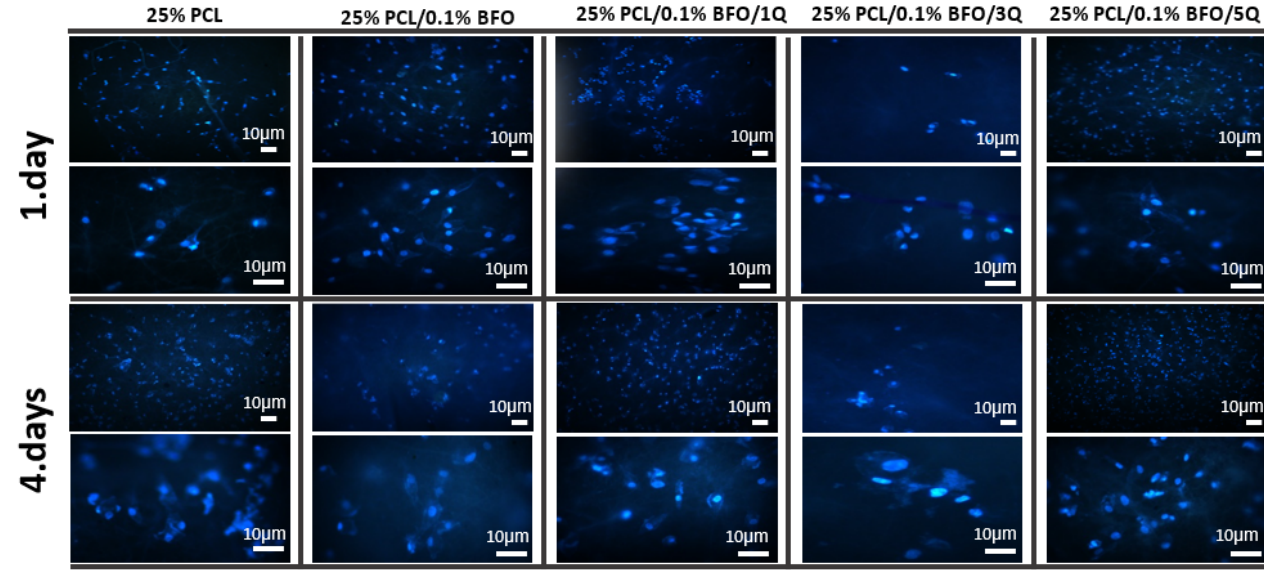
Figure 12. Fluorescence images of MSC viability on the microfibrous scaffolds after 1 and 4 days of the culture period.